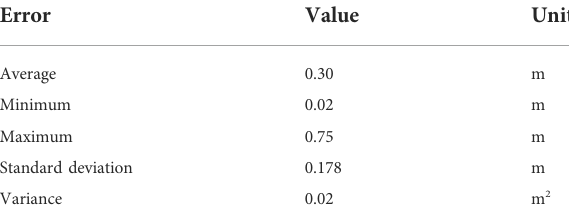
TABLE 2 Task 2: Statistical indexes of the estimation errors in the positions of the obstacles. Error Value